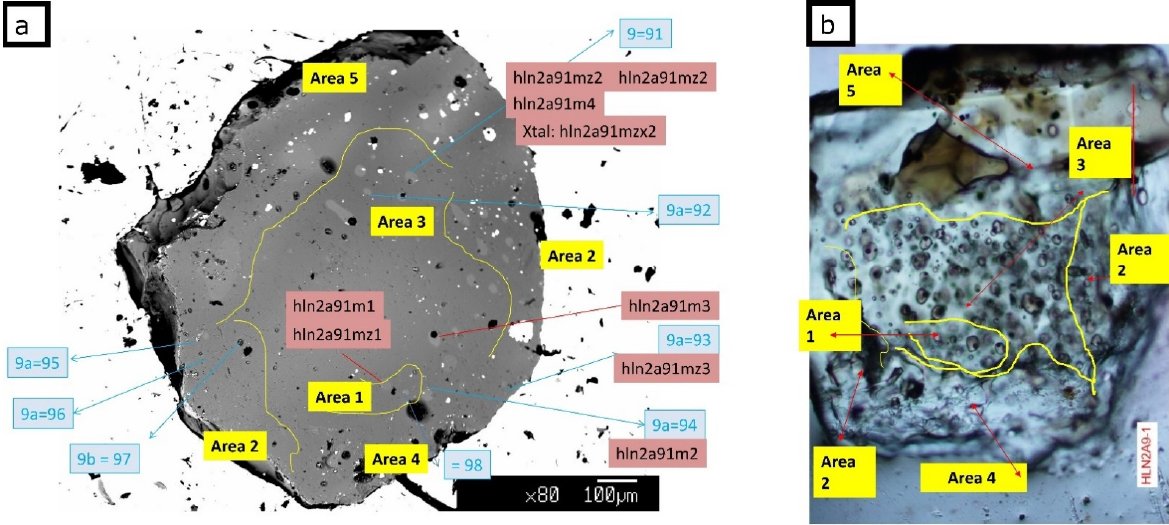
Figure 4. Sample HLN2A91 and analytical spots. ( a ) Electron microprobe image with backscattered electron image (BEI) showing intersected inclusions on crystal HLN2A91. In total five different sectors are showing different kind of inclusion textures for which we attribute the letter “A “. Red rectangles with black letters correspond to EMPA results while blue rectangles with blue letters to FTIR results. ( b ) Microscope image of sample HLN2A91 with different sectors. Area 1 (A1): Spherical glassy inclusion with bubbles (still not classified as typical shrinkage bubble), but also without bubbles (best preserved). Area 2 (A2): Irregular elongated glassy inclusion with bubbles. Area 3 (A3): Spherical glassy inclusion with bubbles. Area 4 (A4): Glassy transparent elongated inclusions. Irregular closed and open (reentrant) inclusions. Isolated dark cubic/angular opaque solid oxide phases. Area5 (A5): Glassy coffee translucid elongated inclusions. Irregular closed and open (reentrant) inclusions. Additionally, they contain cubic/angular dark coffee color and black opaque solid oxide phases.